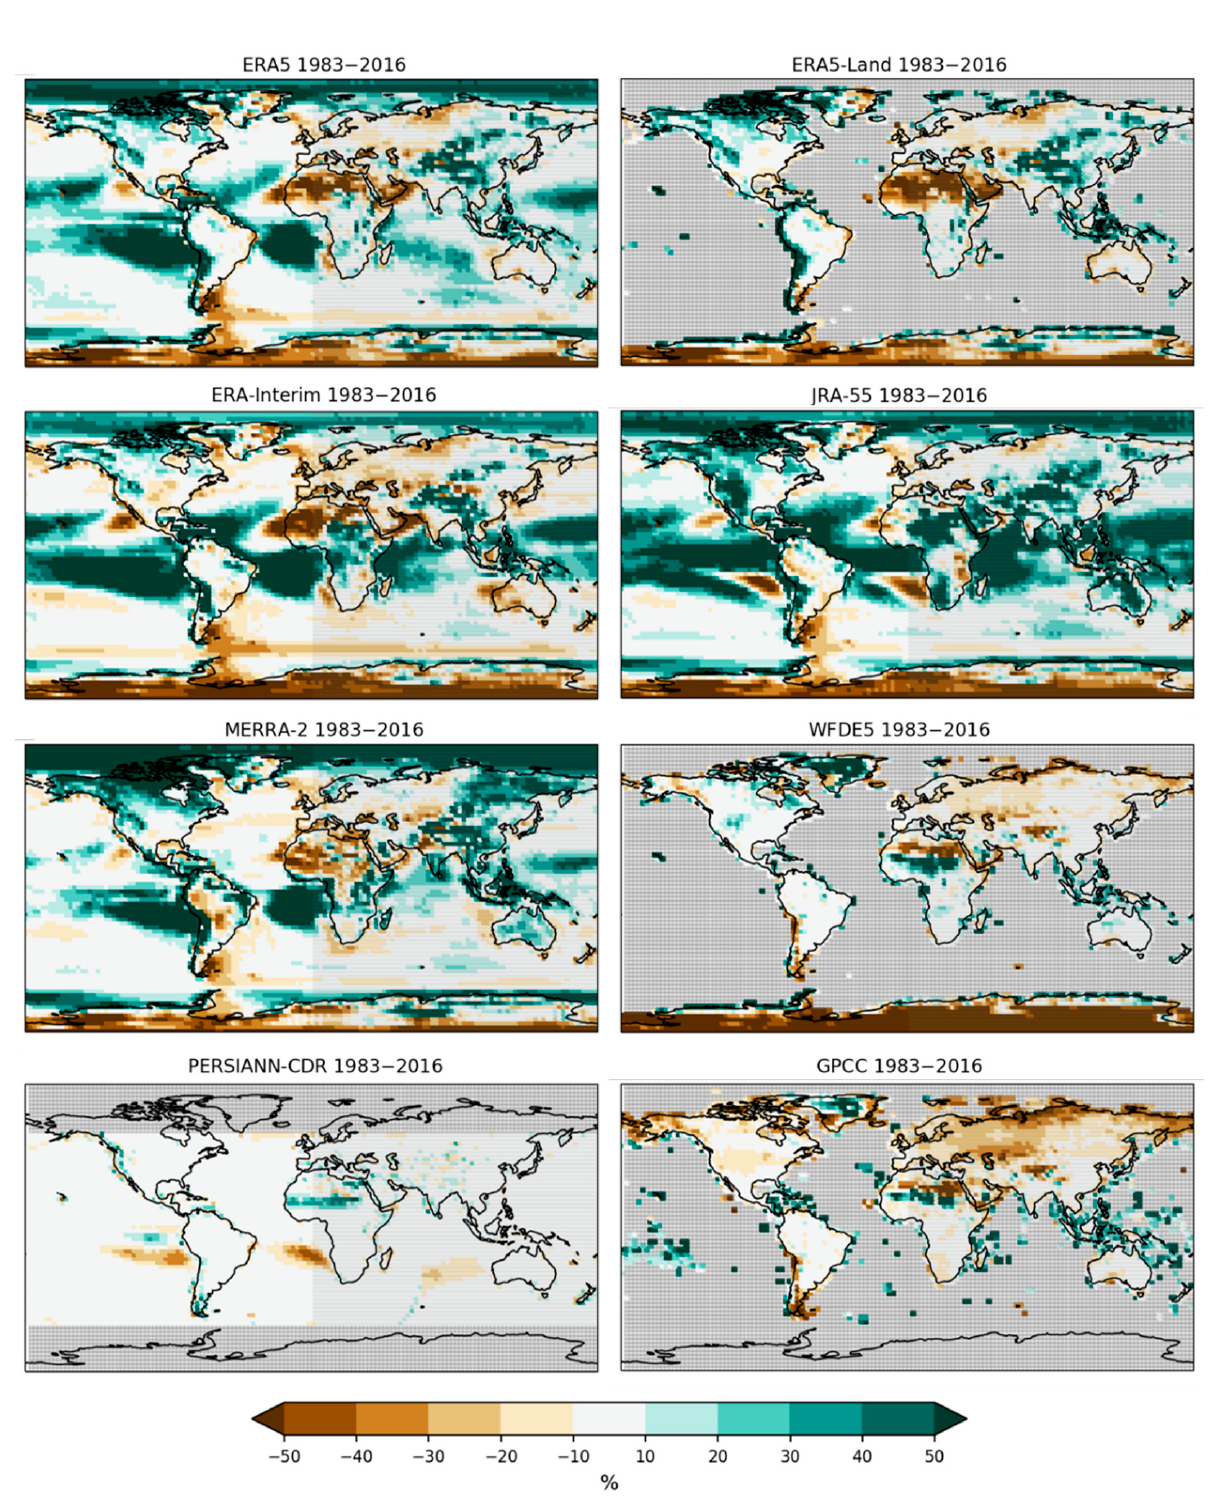
Figure 3. Relative differences (bias) of the multi-year annual means for eight datasets in % with respect to the observational dataset GPCP-SG (reference dataset), averaged over the time period 1983–2016. Green colors correspond to a wet bias, brown colors to a dry bias. Gray grid cells indicate no data.